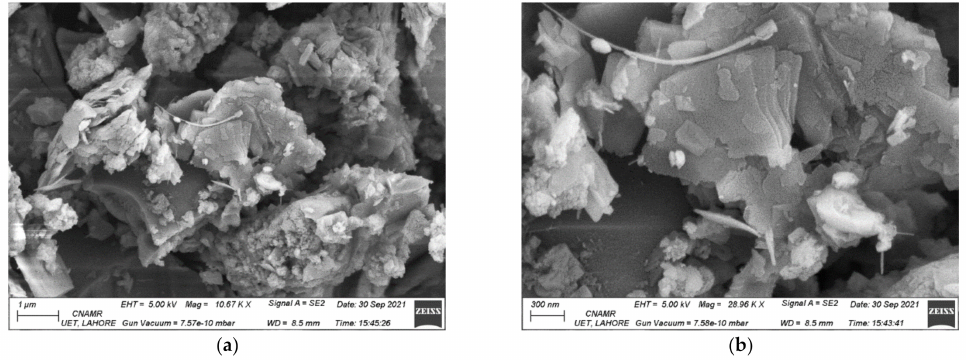
Figure 6. ( a ) FESEM at 1 µ m, ( b ) FESEM at 300 nm.